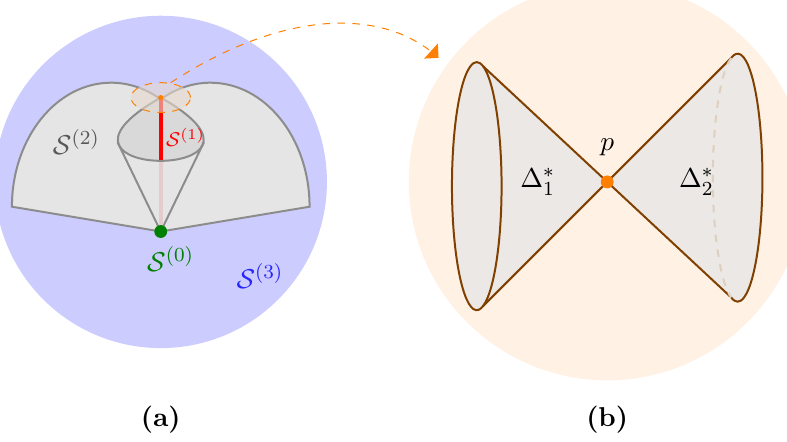
Figure 2. Figure (a) shows a 3-dimensional scale-invariant Coulomb branch, where each real di- mension in the (cid:12)gure represents 1 complex dimension and where (part of) a 2-dimensional compo- nent S (2) self-intersects along a 1-dimensional stratum S (1) . Also shown is a neighborhood (orange disk) in a transverse slice in S (3) through a point p 2 S (1) (orange dot). Figure (b) depicts the intersection of this neighborhood with S (2) , where now each real dimension in the (cid:12)gure represents 1 real dimension. The intersection with S (2) is the disjoint union of two punctured disks, (cid:1) (cid:3) pictured as cones with the point p as their common